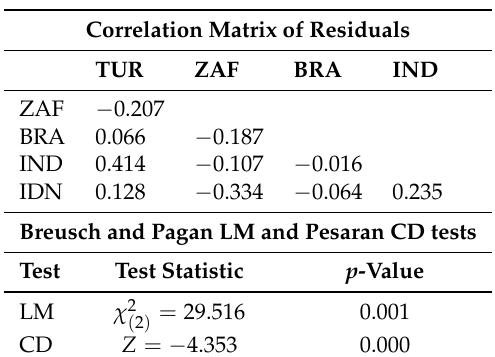
Table 6. Cross-section dependence test results. LM, Lagrange multiplier; CD, cross-section dependence.